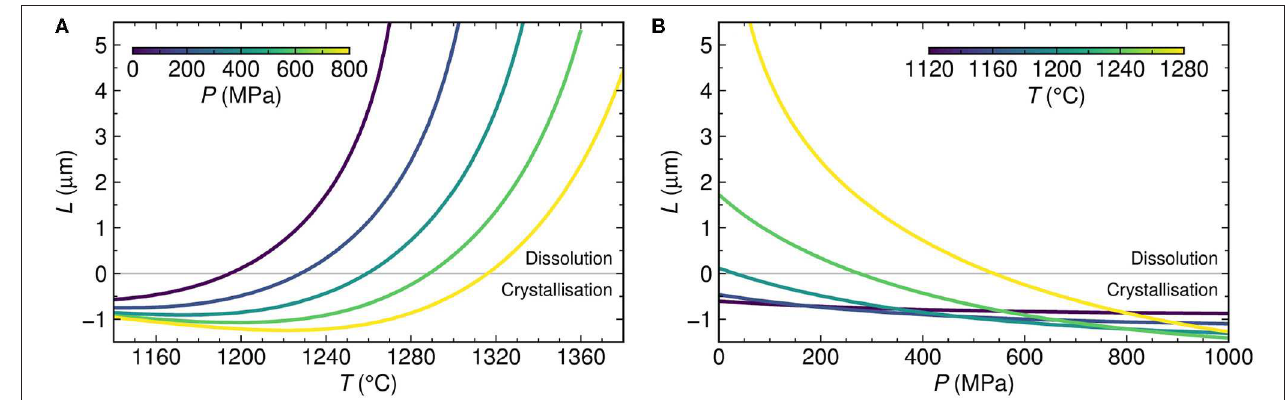
FIGURE 7 | The stability of nodule clinopyroxene cores in the Borgarhraun lava flow as functions of pressure and temperature. Colored lines show the length that the mean nodule clinopyroxene core composition is predicted to dissolve or crystallize in 1 s under different pressure and temperature conditions according to the model of Chen and Zhang (2009). Calculations were performed assuming dissolution into or crystallization from the Borgarhraun matrix glass composition reported by Sigurdsson et al. (2000). (A) Isobaric calculations performed at a range of temperatures. (B) Isothermal calculations performed at a range of pressures.